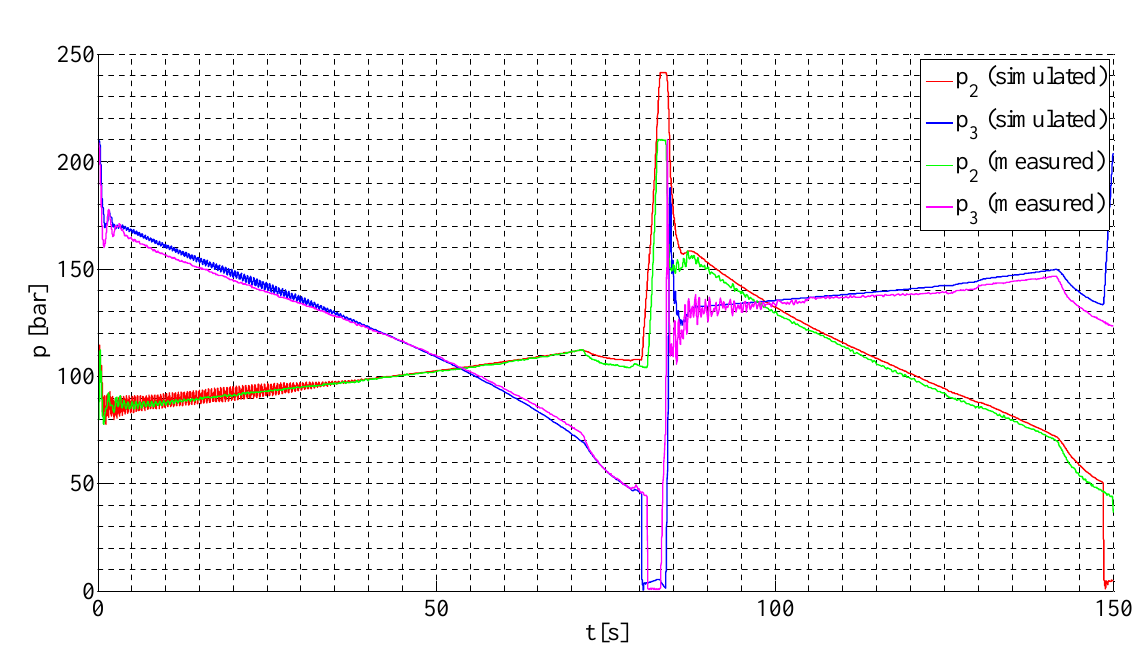
Figure 18: Measured and simulated pressures for verification of steady-state characteristics. tain parameters related to the amplitude of the oscilla- tions than for the frequency. Therefore some deviations are to be expected. Fig. 19 shows the simulated and measured pressures after the